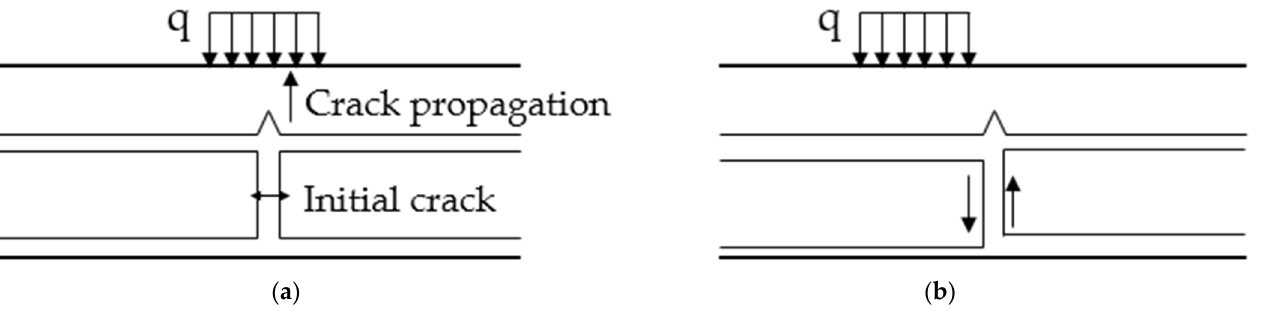
Figure 10. Wheel load distribution schematic drawing for different loads. ( a ) Symmetrical load; ( b ) asymmetrical load.